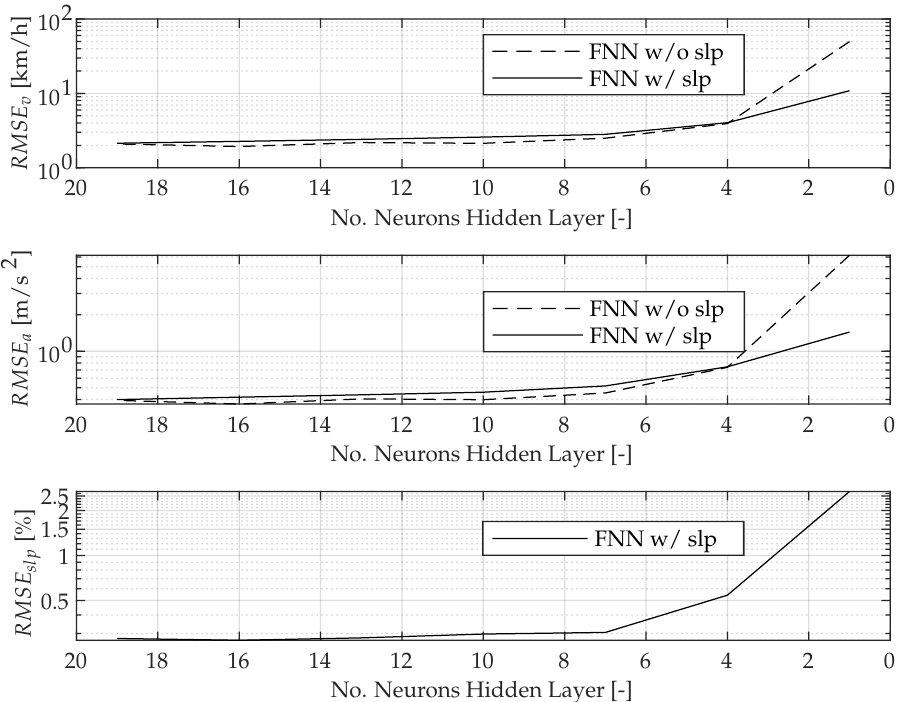
Figure 8. Parameter study: RMSE as a function of the number of neurons in the hidden layers. Further parameter analyses are not discussed at this